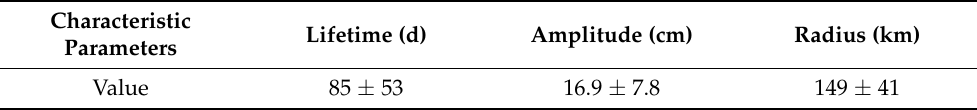
Table 3. Characteristics of the local wandering mesoscale eddies.